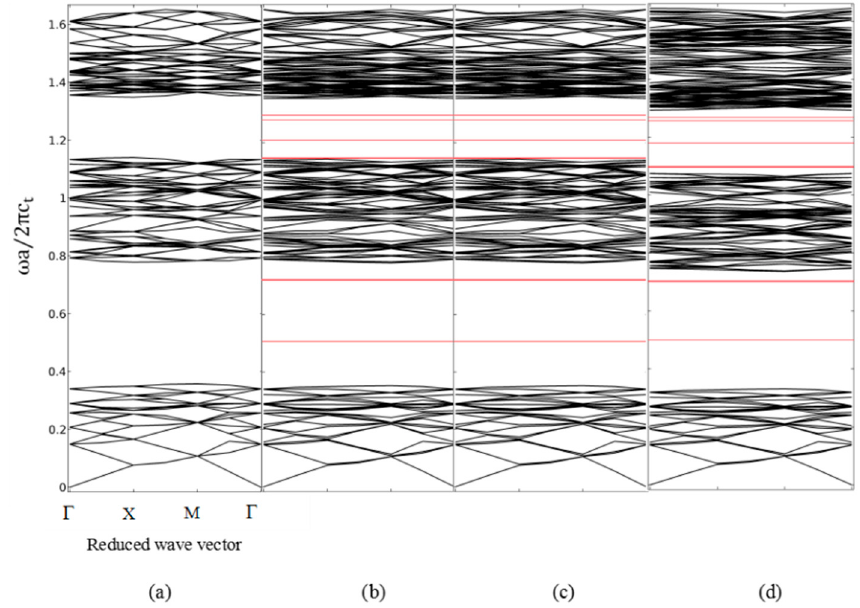
Figure 13. The band structure ( Z mode) of the M-E PC with point defect under different magnetic fields. ( a ) perfected M-E PC at σ z = 0 MPa, H z = 0 kOe. ( b ) σ z = 0 MPa, H z = 0 kOe without PZT-5A. ( c ) σ z = 0 MPa, H z = 0 kOe with PZT-5A. ( d ) σ z = 0 MPa, H z = 1 kOe with PZT-5A.